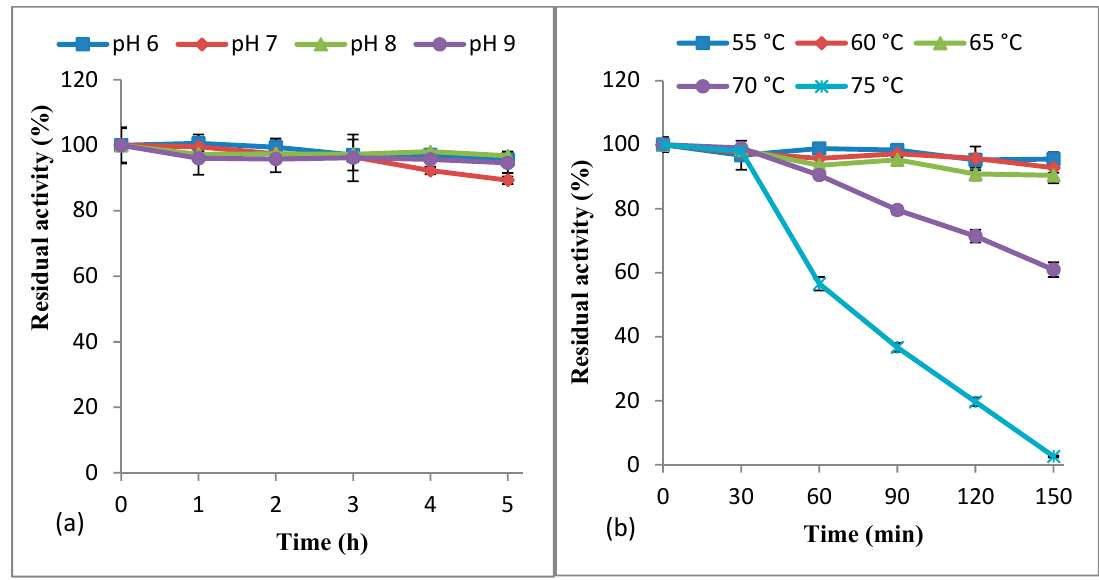
Figure 6. Effect of ( a ) pH and ( b ) temperature on KerBNK1 stability. Each point represents the mean value of triplicate assays.